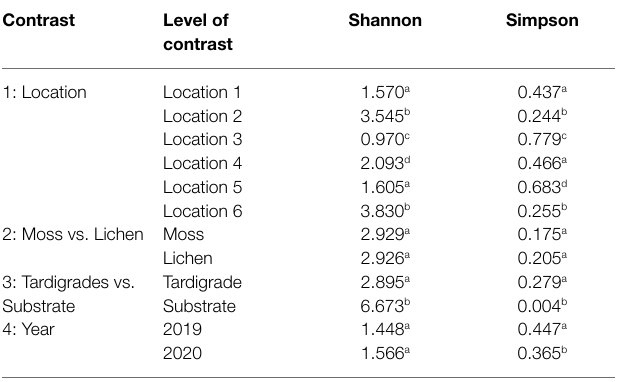
TABLE 2 | Alpha diversity measures Shannon and Simpson estimated for each level of each contrast of